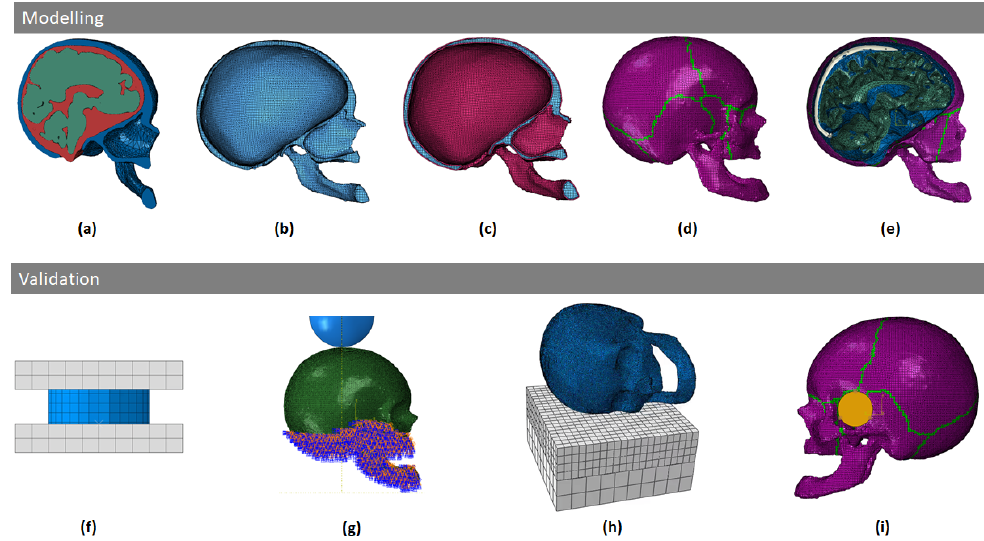
Figure 1. Modeling and validation stages: ( a ) YEAHM original skull model; ( b ) trabecular bone structure; ( c ) trabecular bone covered by the cortical layers; ( d ) sutures inclusion; ( e ) adding of intracranial contents; ( f ) trabecular bone compression; ( g ) blunt impact against stationary skull; ( h ) simulation of falls—lateral impacts; ( i ) blunt ballistic temporo-parietal head impacts.